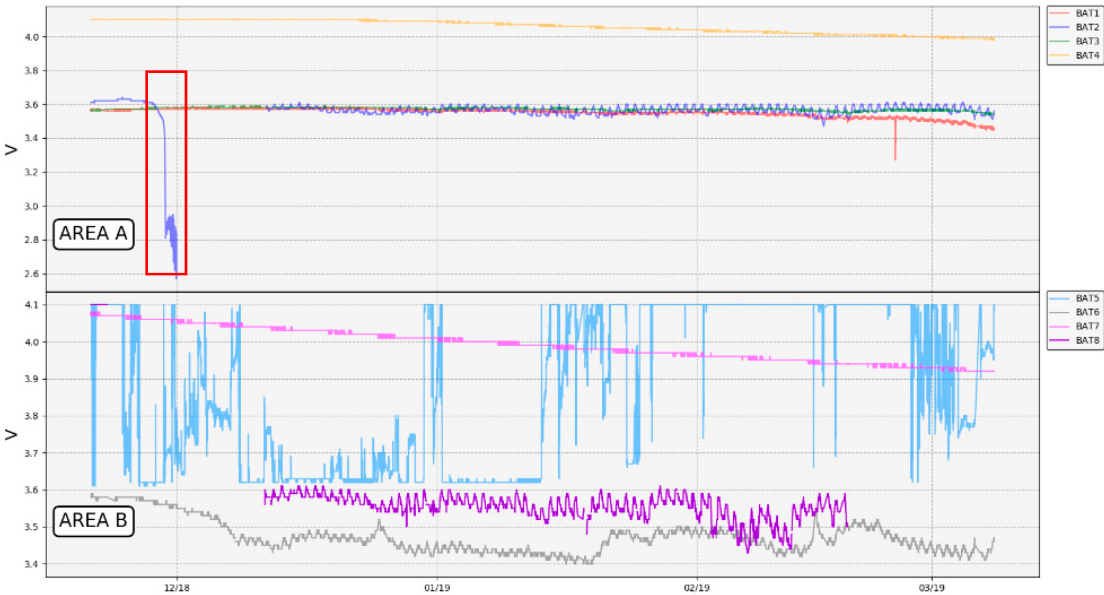
Figure 15. Battery records. The red rectangle highlights the T2 battery drain due to overheating.